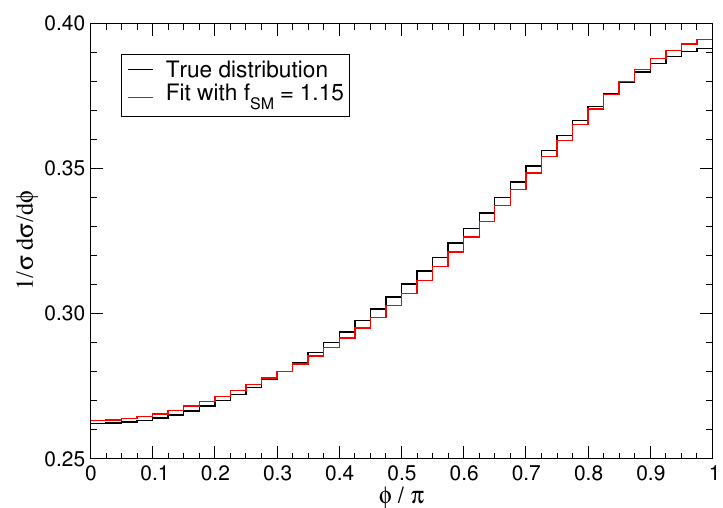
Figure 2 . Normalised d(cid:27)=d(cid:30) distribution (in bins of (cid:25)= 40) for a non-SM spin correlation yielding f SM = 1 : 15 in eq. (1.3), and best-(cid:12)t function g ( (cid:30) ; f SM ) with f SM = 1 : 15. The CM energy is 8